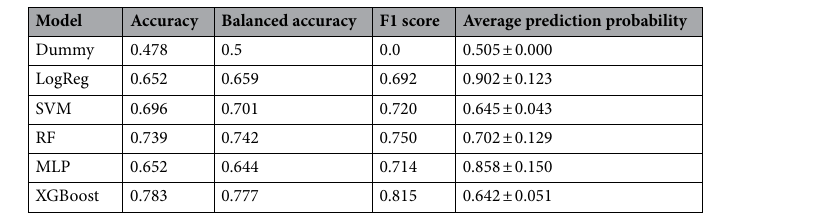
Table 2. Classification performance of the machine learning models. LogReg logistic regression, SVM support vector machine, MLP multi-layer perceptron, RF random forest, XGBoost extreme gradient boosting.